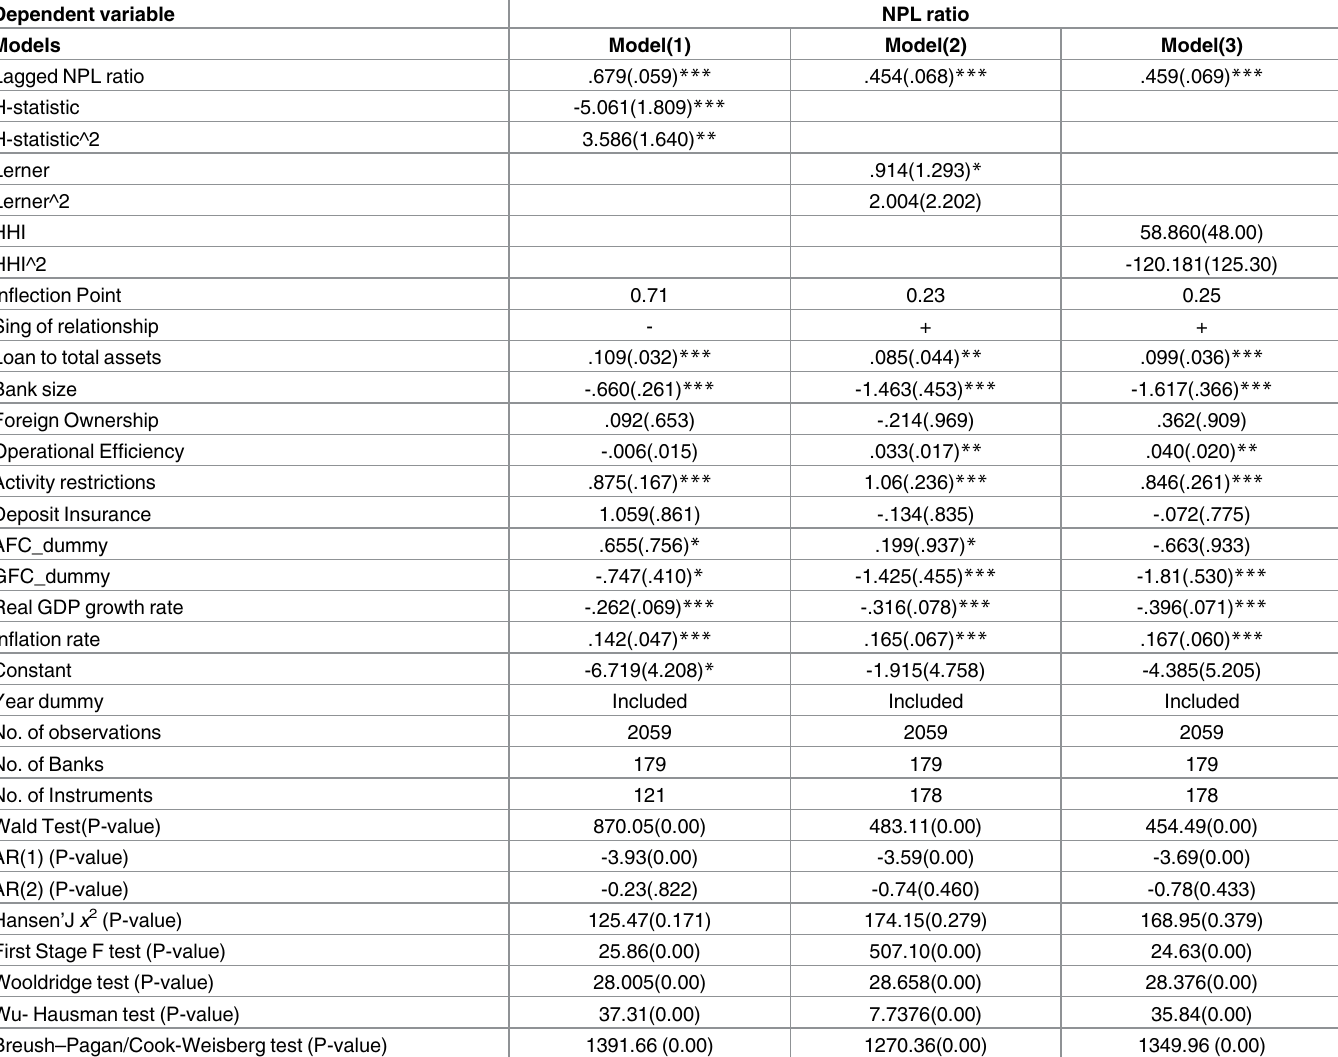
Table 5. The effect of competition measuredby H-statistic, Lerner index and HHI on NPL ratio as a measureof financial stability in ASEAN-5 from 1990–2014period. Dependent